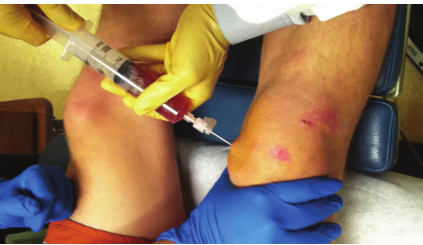
Figure 4: Using ultrasound for needle placement, 38mL serosan- guinous fluid was